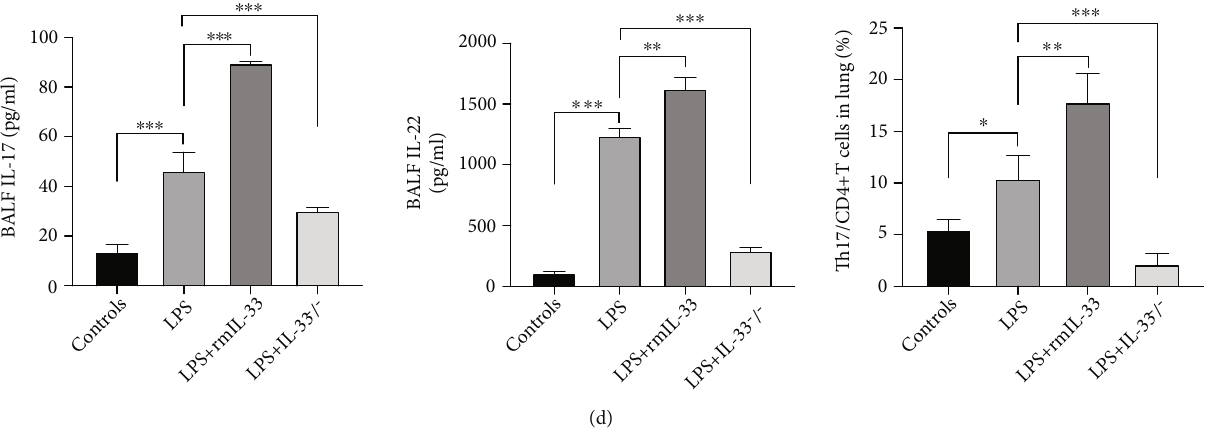
Figure 4: IL-33 de fi ciency inhibited Th17 cells in murine ARDS. (a) The percentage of CD4+ IL-17+CD4+ T cells in the lung was detected by fl ow cytometry. (b) The mRNA expression of ROR γ t in the lung was measured by real-time PCR. (c) The protein expression of ROR γ t in lung tissue was measured by Western blotting. (d) The concentrations of IL-17 and IL-22 in BALF were detected by ELISA. The data are expressed as the means ± SDs . Signi fi cant di ff erences are shown by ∗ P < 0 : 05 , ∗∗ P < 0 : 01 , and ∗∗∗ P < 0 : 001 by one-way ANOVA followed by Bonferroni ’ s post hoc test comparing the WT control, LPS, LPS+rmIL-33, and LPS+IL-33 -/- groups. N = 3 ‐ 5 for each group, and three independent repeated experiments were carried